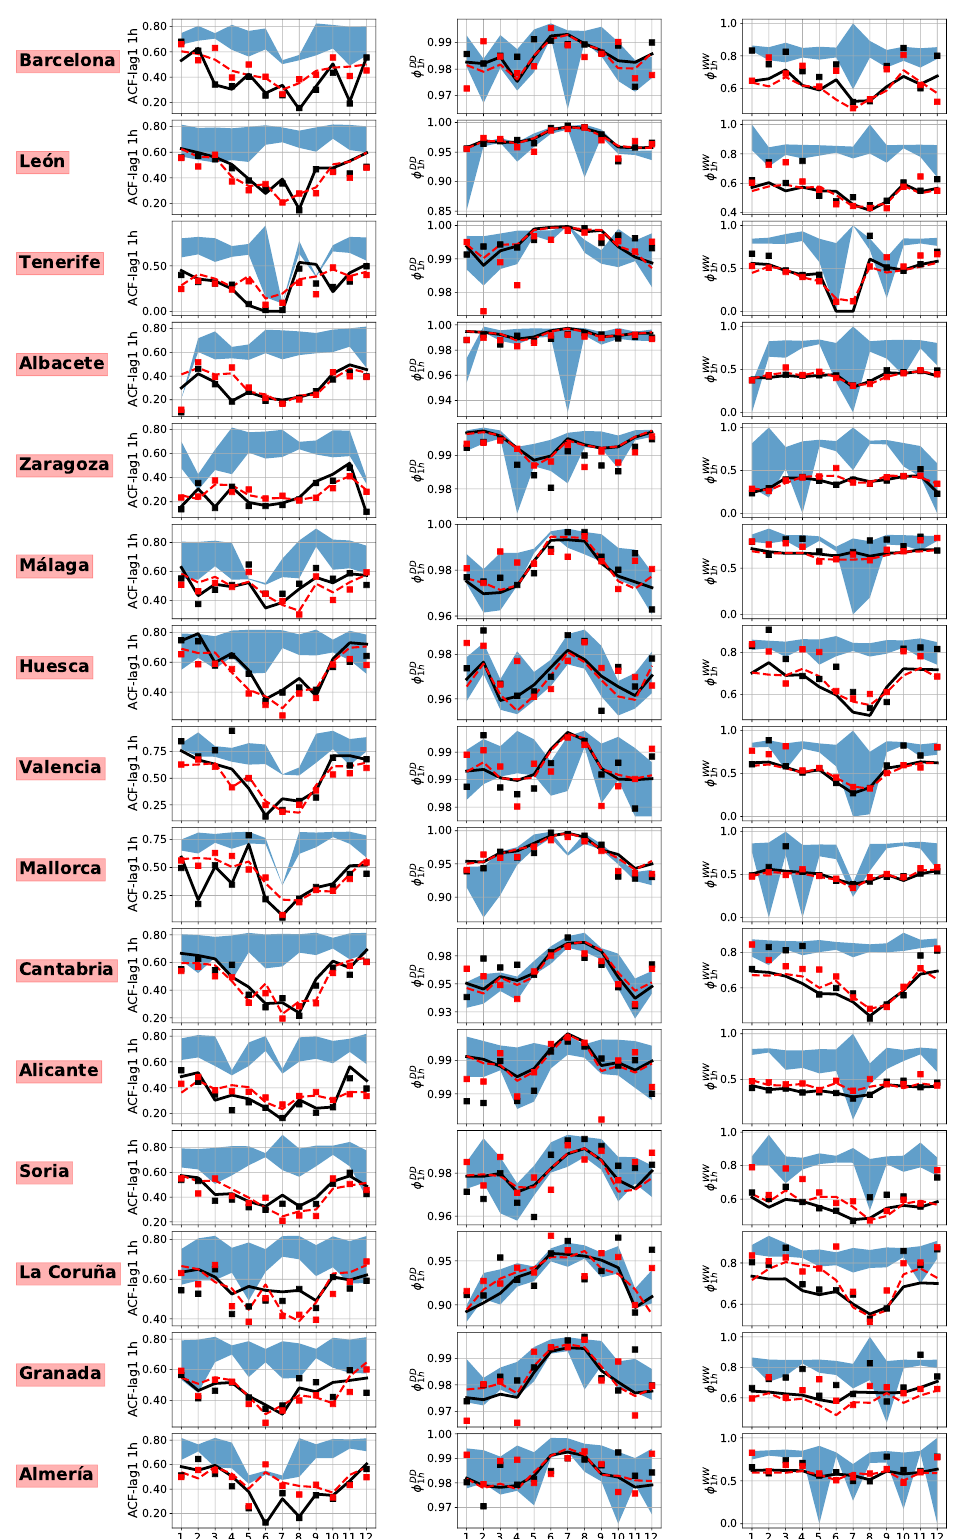
Figure 7. One-hour rainfall performance of the NSRPM simulation of ACF-lag1, φ DD and φ WW . Black color corresponds to the “exact scenario”; the line and squares represent, respectively, the observed and simulated 1-h statistics. Red color corresponds to the “target scenario”; the dashed-line and squares represent, respectively, the RFB-predicted and the simulated 1h-statistics. The blue-hatched area shows the range of statistics for the calibration in the “simple scenario”. Each row corresponds to a case